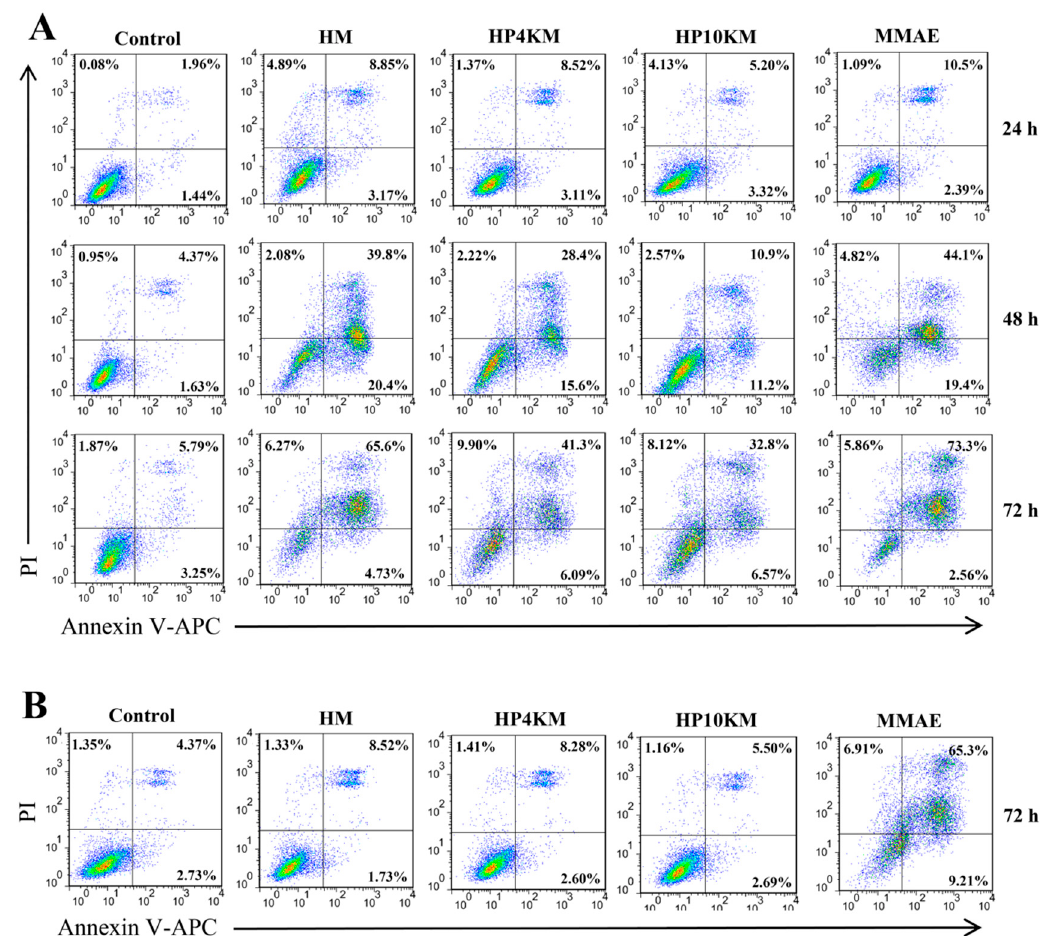
Figure 5. Apoptotic mechanism of the conjugates analyzed by flow cytometry. HER2-positive NCI-N87 cells ( A ) were treated with 200 nM of the conjugates for 24, 48, and 72 h, or HER2-negative PC-3 cells ( B ) were treated with 200 nM of the conjugates for 72 h, stained with Annexin V-APC/PI and analyzed for apoptosis by flow cytometry.